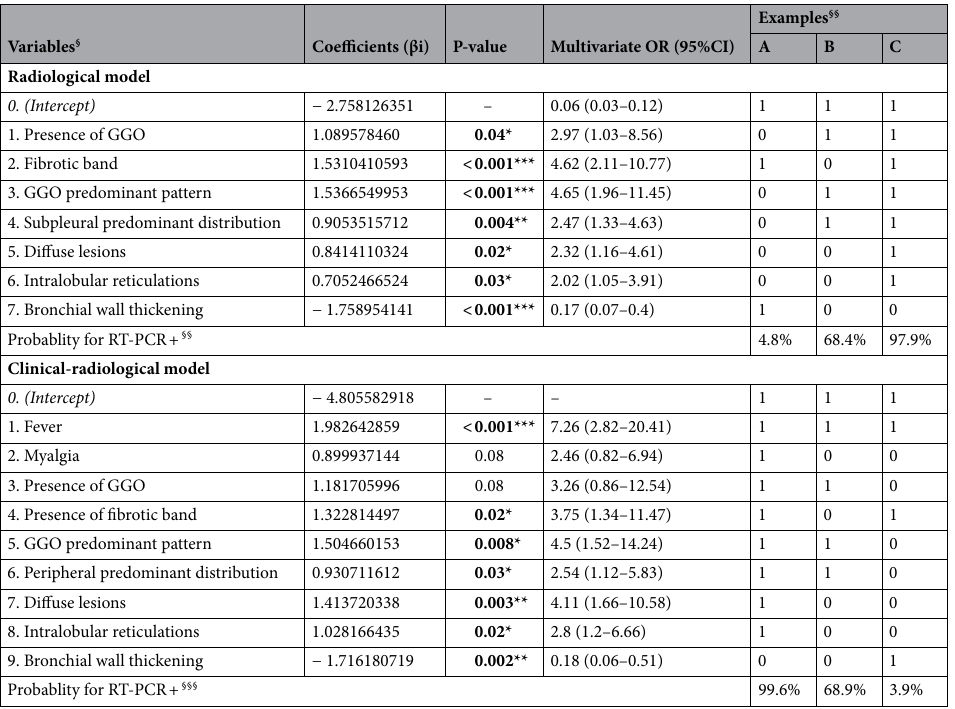
Table 4. Final multivariate stepwise binary logistic regression models elaborated with either radiological or clinical-radiological variables. Significant results are highlighted in bold. 95%CI 95% confidence interval; GGO ground glass opacity; OR odds ratio. § The variables correspond to those in the final model after the stepwise backward-forward selection. §§ Examples correspond to 6 distinct clinical cases. Each variable has 2 levels: “1” if the variable Xi is present (for instance fever), and “0” if the variable Xi is absent (for instance lack of fever). §§§ The probability for RT-PCR + are calculated as follows: P(RT-PCR +) = 1 / 1 + exp [− (β 0 + (cid:31) 9 i = * P < 0.05, ** P < 0.005, *** P <